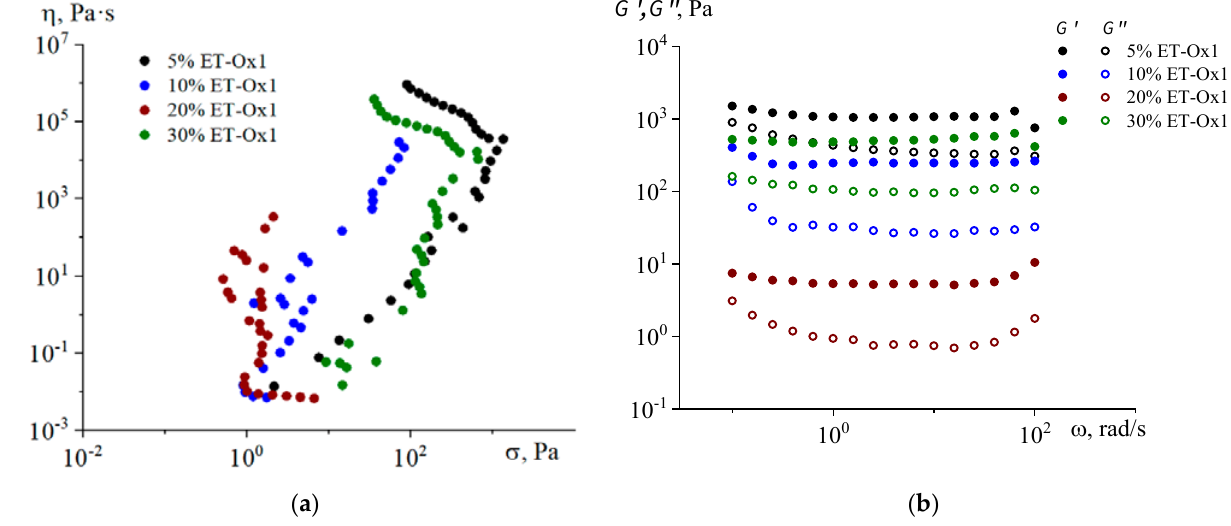
Figure 3. Dependence of viscosity on shear stress ( a ) and frequency dependences of storage and loss moduli ( b ) of paraffin composites containing ET ‐ Ox1 asphaltenes, T = 80 °C.